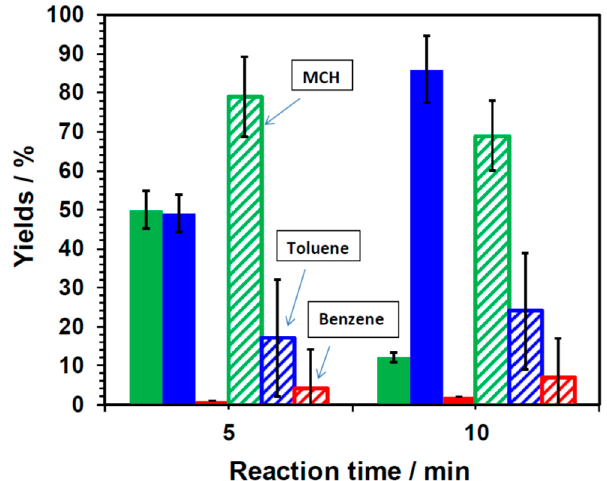
Figure 6. Percent yields of toluene as a function of reaction times from the dehydrogenation of methylcyclohexane (MCH), and yields of the by-product benzene in Pt / AC with methylcyclohexane as the solvent under irradiation with variable frequency microwaves (VFM; solid colors) at 5.85–6.65 GHz and with fixed frequency microwaves (FFM; striped colors) at 5.85 GHz. (Green: MCH; Blue: toluene; Red: benzene).